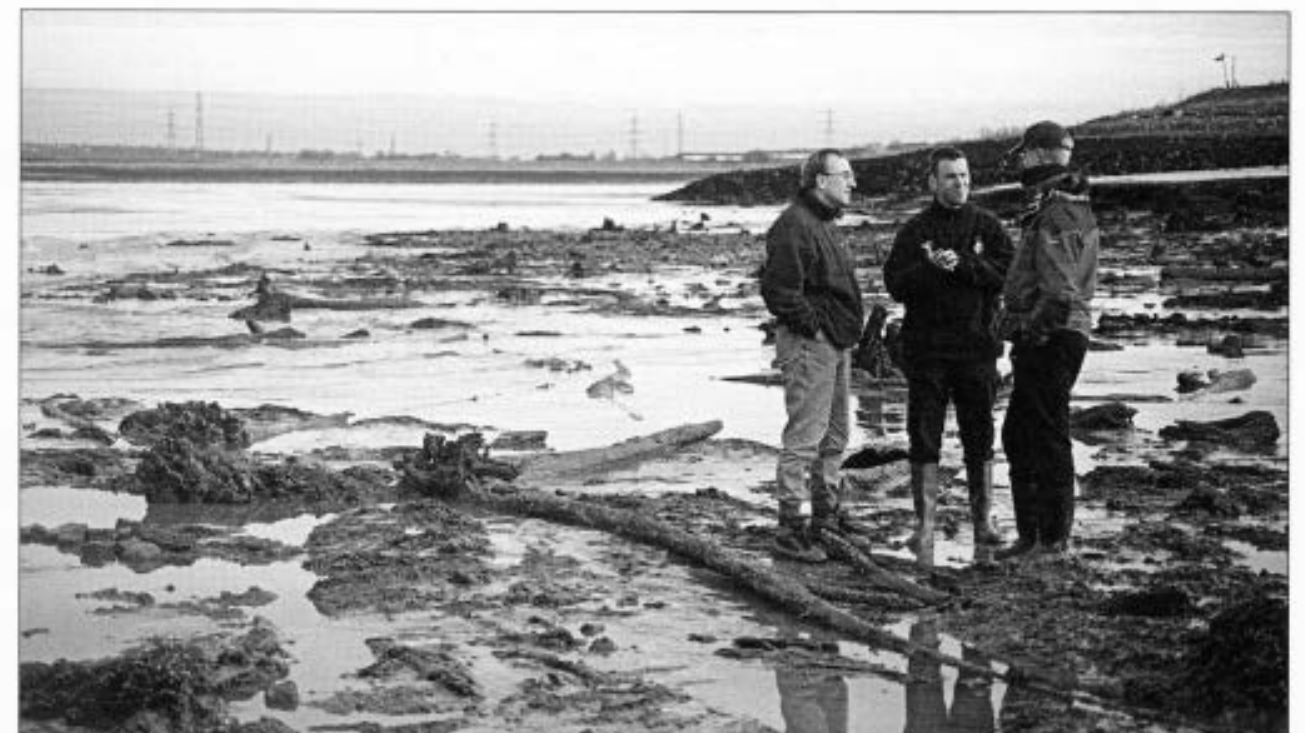
Figure 3 Part of the Neolithic to Iron Age buried forest on the southern foreshore of the Thames at Erith on the border of London and Kent; yew-tree trunks on the surface in the foreground; 18 species of trees have so far been recorded from this 1 km-long